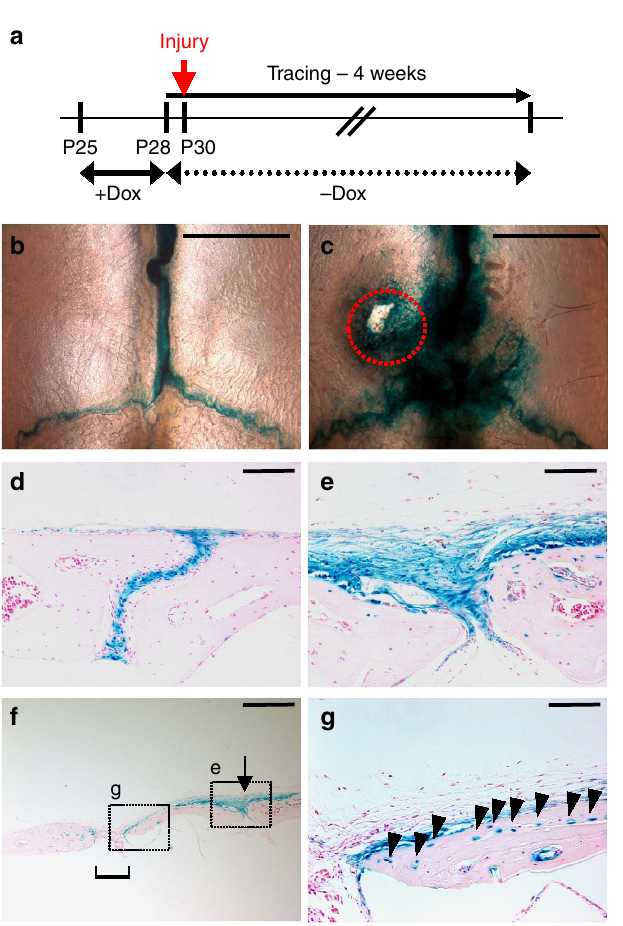
Figure 4 | Injury-induced expansion of Axin2-expressing cells undergoing osteoblast differentiation for skeletal repair. ( a ) A diagram illustrates our strategy to map the Axin2-expressing cell fate in an injury repair model. Tracing analysis assesses the population of the Axin2-expressing cells and their descendants with ( c , e – g ) or without ( b , d ) injury in whole mounts ( b , c ) and sections ( d – g ) of the b -gal-stained Axin2 Cre-Dox ; R26R mice. Bracket, arrow and arrowheads indicate the unhealed region, suture mesenchyme and osteocytes in newly regenerated bones, respectively. Images are representatives of three independent experiments. Scale bar, 2mm ( b , c ). Scale bar, 100 m m ( d , e , g ). Scale bar, 400 m m ( f ).